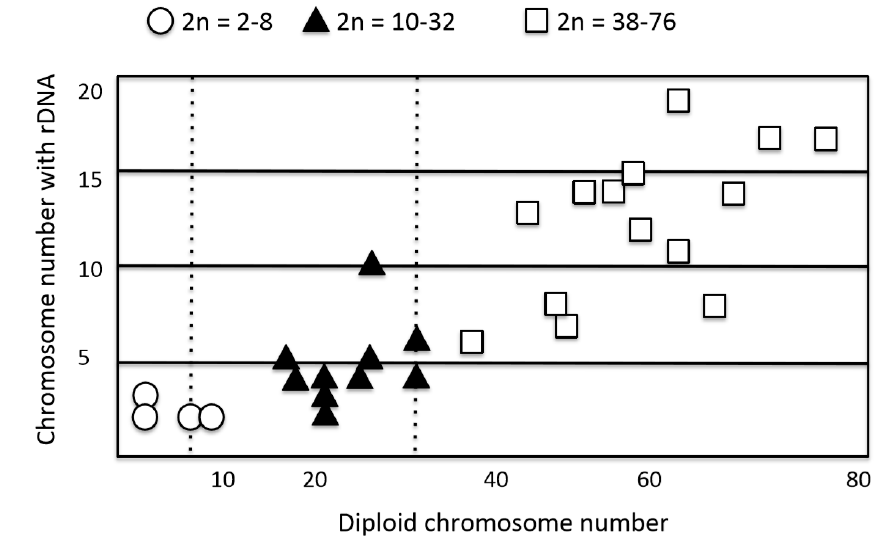
Figure 3. Relationship between diploid chromosome number and NOR chromosome number detected using rDNA probes in Australian bulldog ants. The gulosa group: M. arnoldi 2n = 53 − 66; M. forficate 2n = 52, 54; M. gulosa 2n = 38; M. pavida 2n = 44; M. simillima 2n = 70; M. vindex 2n = 74, 76. The mandibularis group: M. fuvipes 2n = 48, 50; M. mandibularis 2n = 56. The pilosula group: M. banksi 2n = 10; M. chasei 2n = 47; M. croslandi 2n = 3, 4; M. haskinsorum 2n = 18; M. imaii 2n = 8; M. michaelseni 2n = 27; M. occidentalis 2n = 64; M. pilosula 2n = 19, 22, 23, 32.